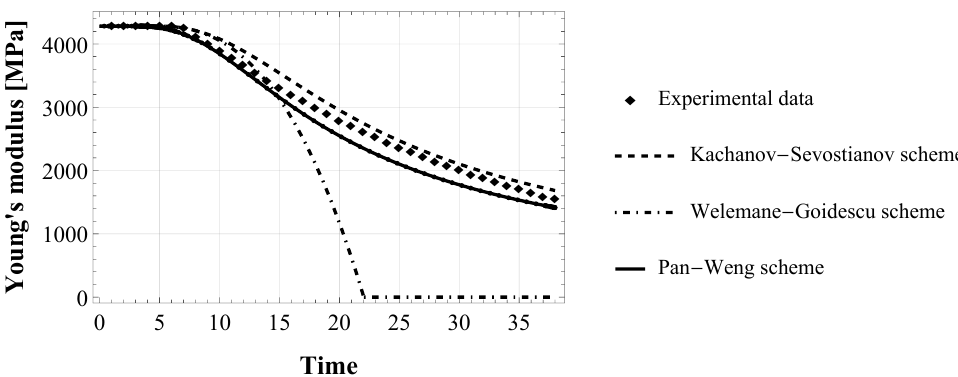
Figure 3. Evolution of the Young’s modulus of the epoxy-based adhesive XA7416: fitting of the proposed numerical model (with Kachanov-Sevostianov, Welemane-Goidescu and Pan-Weng scheme) to the experimental data extracted by authors from experiments by [35].